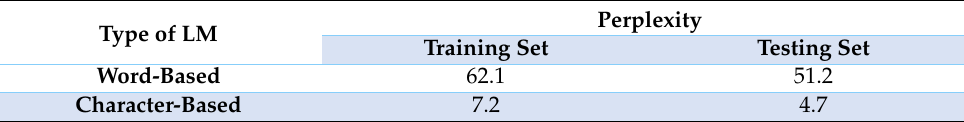
Table 5. Evaluating the effectiveness of building a word- and character-based language model from LSTM neural